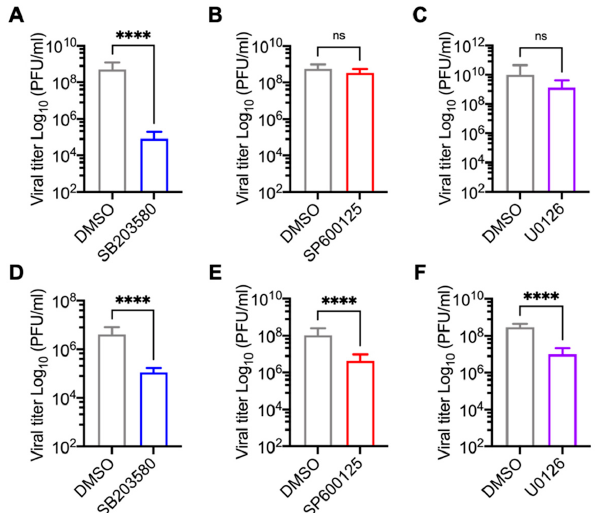
Figure 3. Inhibition of p38 with SB203580 decreases MAYV progeny production in HDFs and HeLa cells. HDFs ( A – C ) or HeLa ( D – F ) were pre-treated with SB203580, SP600125, or U0126 at concentrations of 10, 1, and 10 µM, respectively, for 1 h. Then, the compounds were removed and the cells were infected with MAYV at an MOI of 1 (HDFs) or 10 (HeLa cells). After virus adsorption, the MAPK inhibitors dissolved in fresh medium were added to the cells and incubated for 24 h. Viral progeny production in cell supernatants from each experimental condition was quantified using plaque assay. Statistically significant differences were analyzed with the Mann–Whitney test: **** p < 0.0001 and ns: